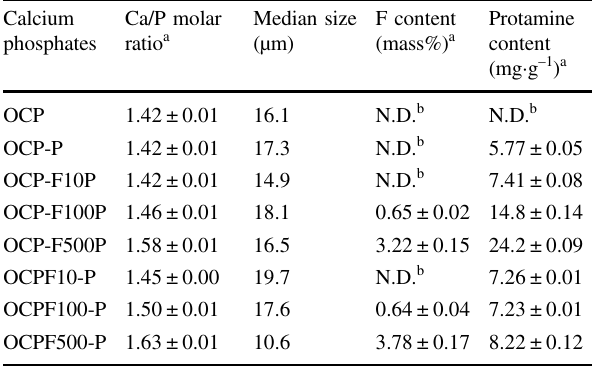
Table 1 Ca/P molar ratio, median size, F content, and protamine content of the prepared calcium phosphates